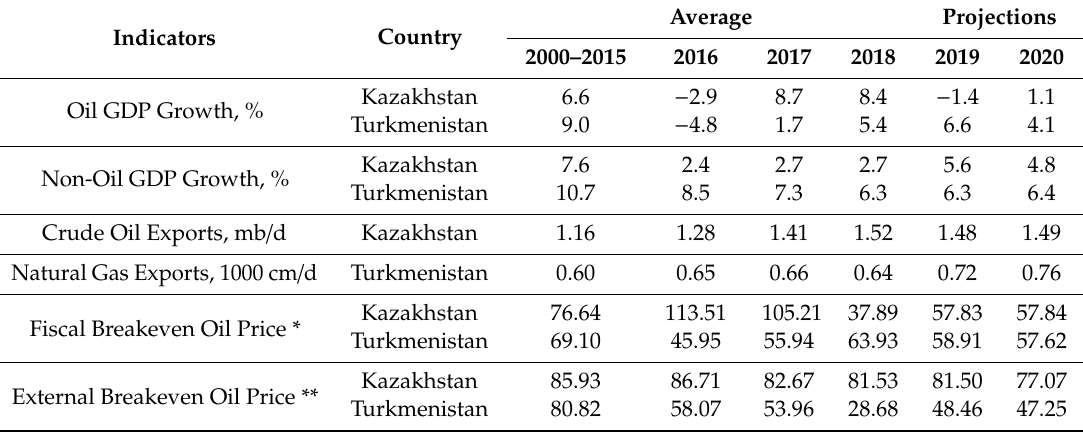
Selected Parameters of Fossil-Fuel-Dependent Economies (Source: retrieved from http: // data.imf.org / ?sk = 4CC54C86-F659-4B16-ABF5-FAB77D52D2E6&sId =